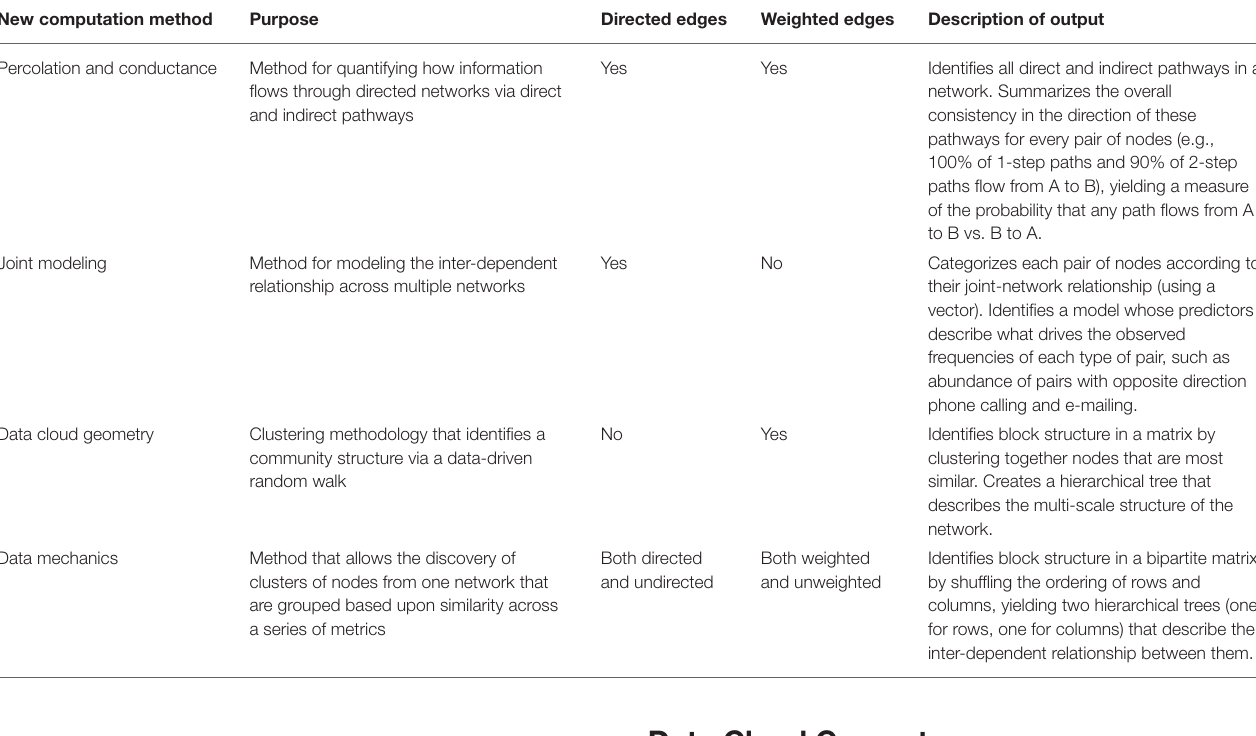
TABLE 1 | Summary of computational network approaches.